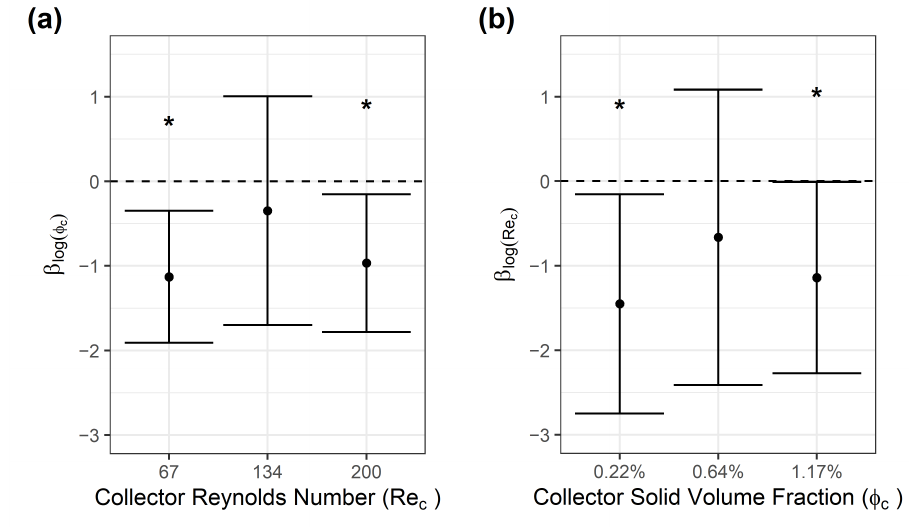
Figure 5. Effect size estimates from Monte Carlo regression analysis, showing the direction and significance of trends in ECE. Error bars represent 95% confidence intervals. Asterisks mark the parameter values at which the effect size was found to be significant. ( a ) Estimates of the effect of log-transformed collector solid volume fraction ( β log ( φ ) on log-transformed ECE, stratified by Re c . c ) ( b ) Estimates of the effect of log-transformed Re c ( β log ( Re ) on log-transformed ECE, stratified by φ c . c )